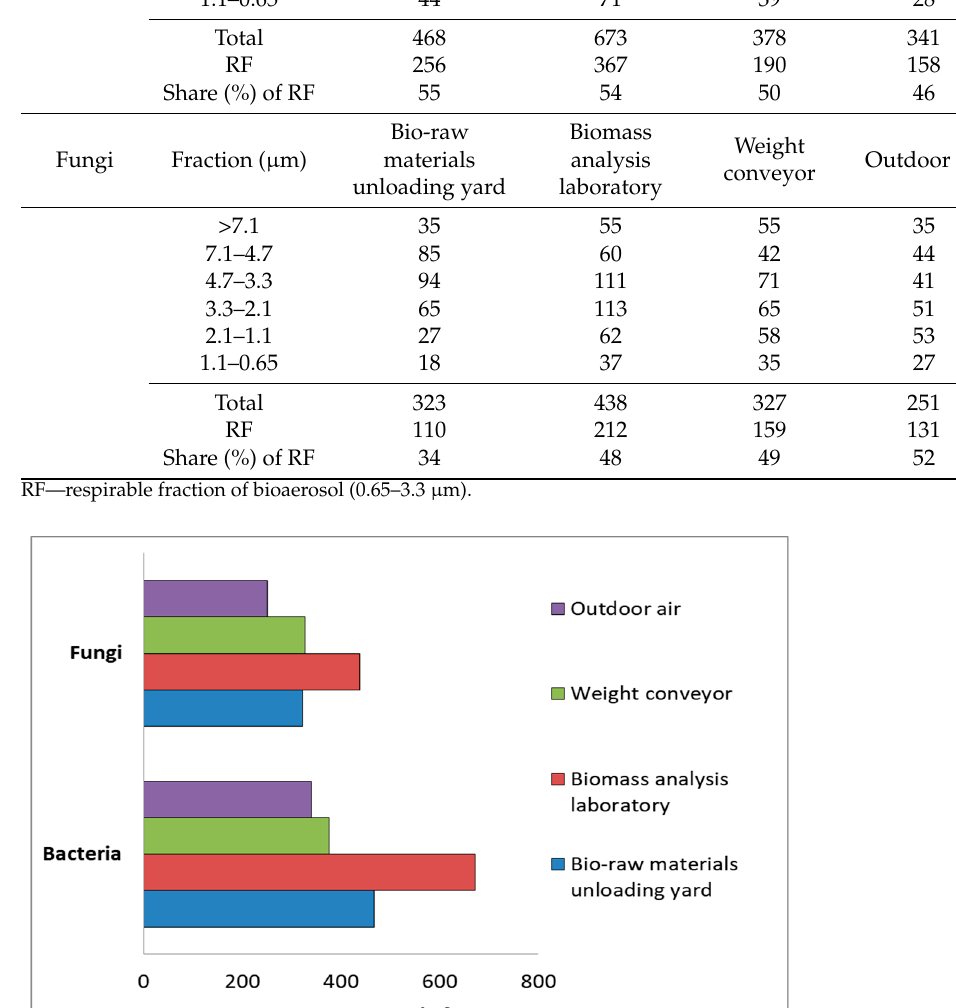
Table 3. The average concentration and size distribution, CFU/m 3 of micro-organism colony-form- ing units per cubic metre.